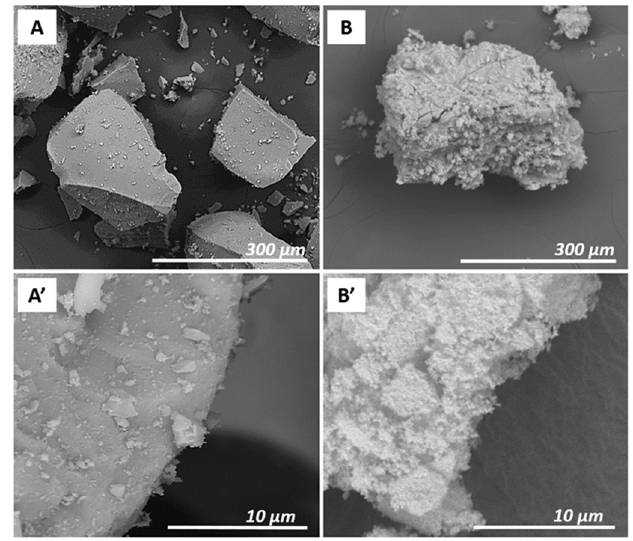
Figure 1. SEM images of PB_Com ( A , A’ ) and PB_Syn ( B , B’ ) at 500× and 10,000× magnifications.